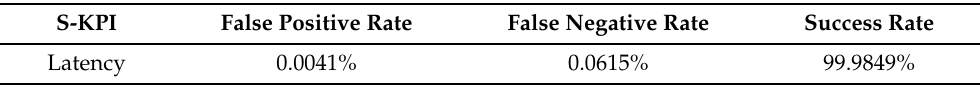
Table 2. Prediction